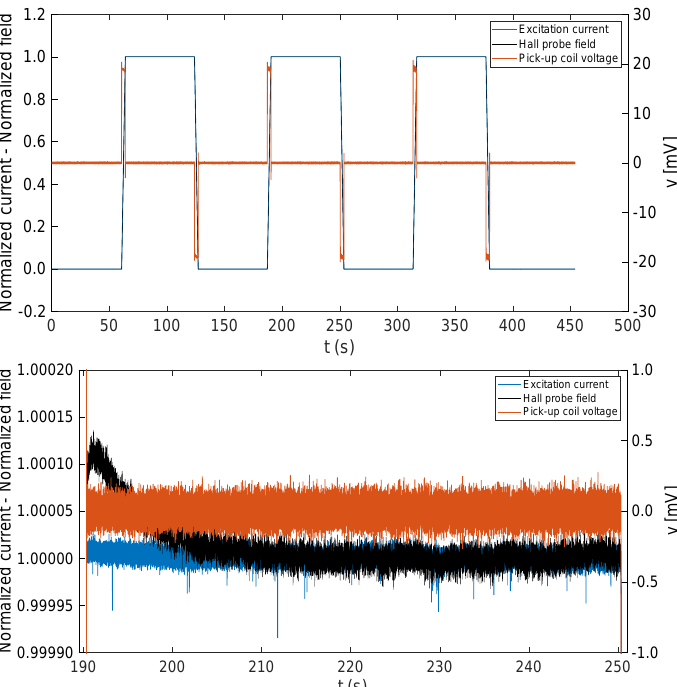
Figure 4. ( Top ) Normalized excitation current, Hall probe field measurements (left vertical axis), and induced voltage in the sensing coil (right vertical axis) ; ( bottom ) zoom on the central